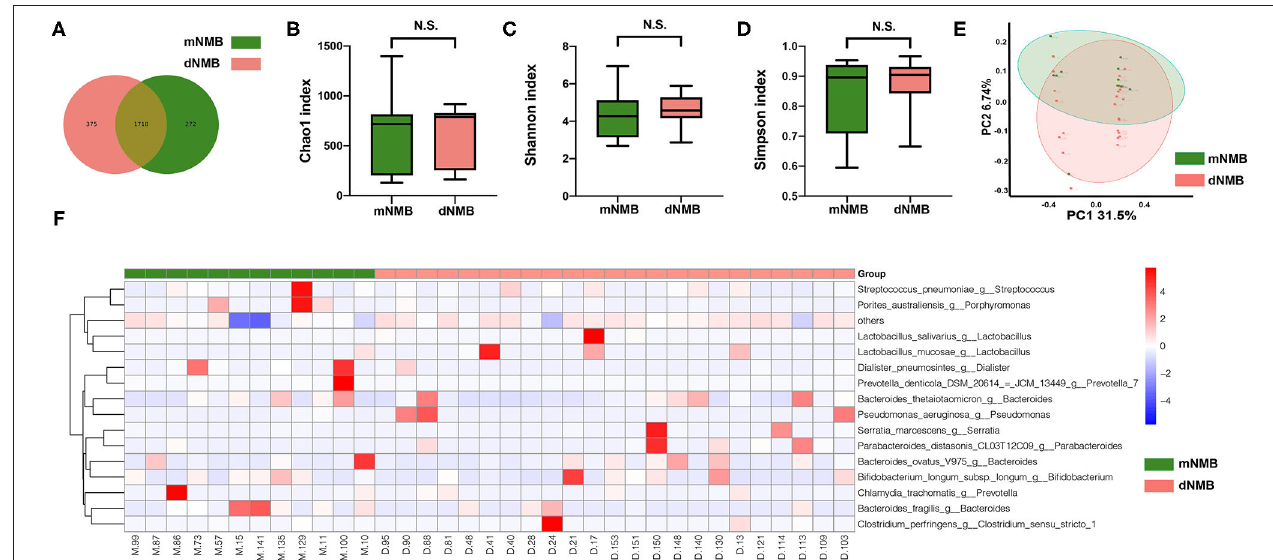
FIGURE 2 | Alpha diversity, Beta diversity, and heatmap of gut microbiota between the deep NMB and moderate NMB group. (A) Venn plot; (B) Chao 1 index; (C) Shannon index; (D) Simpson index; (E) PCoA of gut microbiota; (F) the heatmap at the genus level. dNMB, deep neuromuscular blockade; mNMB, moderate neuromuscular blockade; N.S., not significant; PCoA, principal coordinate